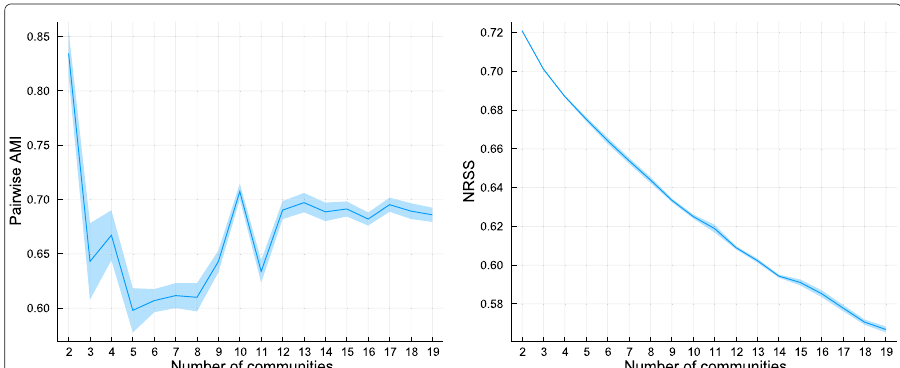
Fig. 8 Choosing the number of communities: PyPI. Left: the mean pairwise adjusted mutual information of the community-node membership across repeated decompositions. 1 is a perfectly stable assignment to communities; 0 is perfectly random. The shaded area corresponds to twice the standard error of the mean. Right: the mean normalised residual sum of squares error for repeated decompositions on the PyPI network against the number of components. The shaded area corresponds to twice the standard error of the mean above and below the line